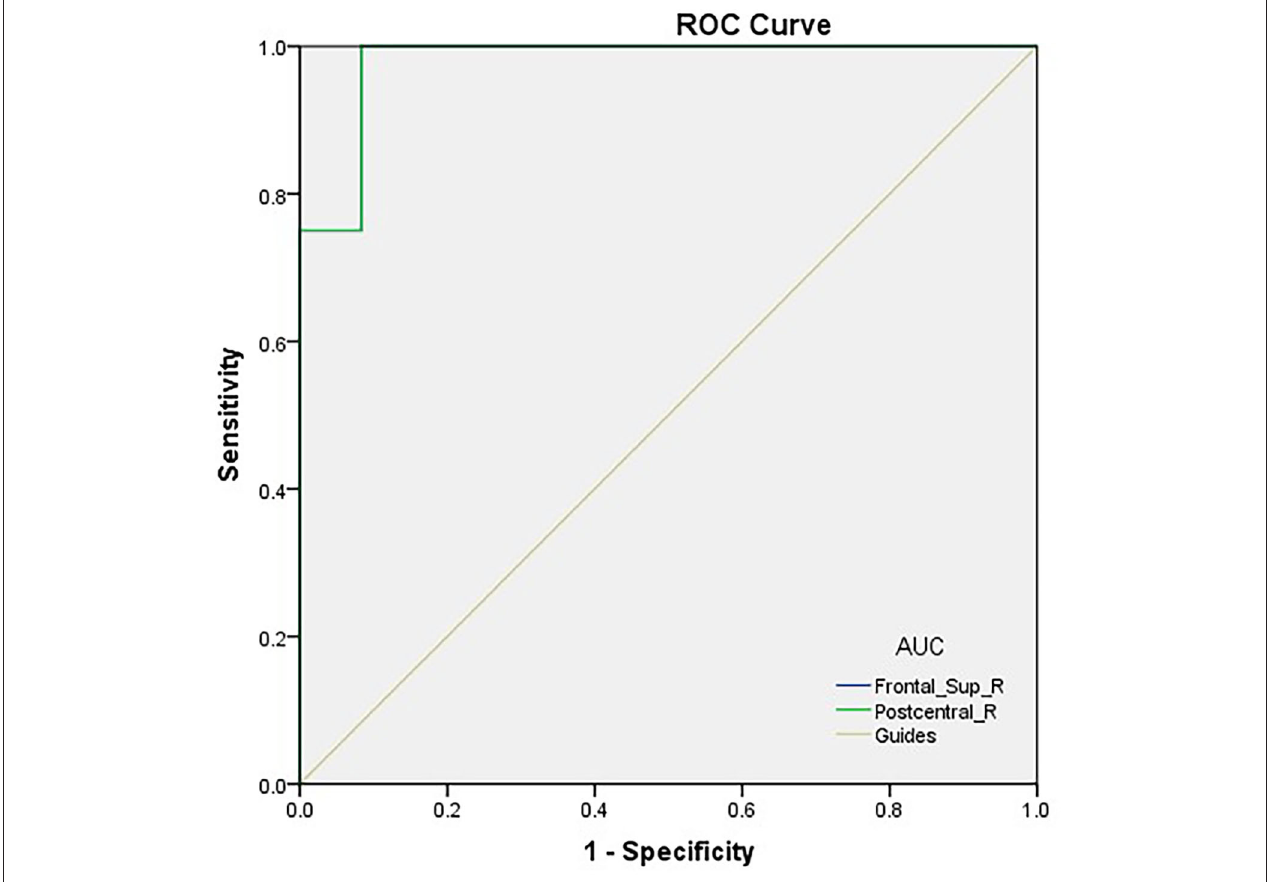
FIGURE 2 | ROC curve analysis of the PerAF values for altered brain regions. ROC curve analysis of the PerAF values for altered brain regions. The area under the ROC curve of the right dorsolateral superior frontal gyrus was 0.979 ( P < 0.0001; 95% CI: 0.931–1.000); the area under the ROC curve of the right posterior central gyrus was 0.979 ( P < 0.0001; 95% CI: 0.931–1.000). ROC, receiver operating characteristic; PerAF, percent amplitude of fluctuation; AUC, area under the curve.